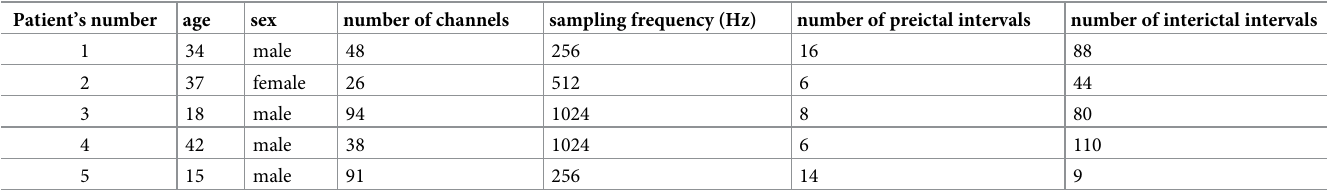
Table 1. Detailed information about patients the from EPILEPSIAE database. [21] The number of preictal intervals is the same as the number of seizures. Patient’s